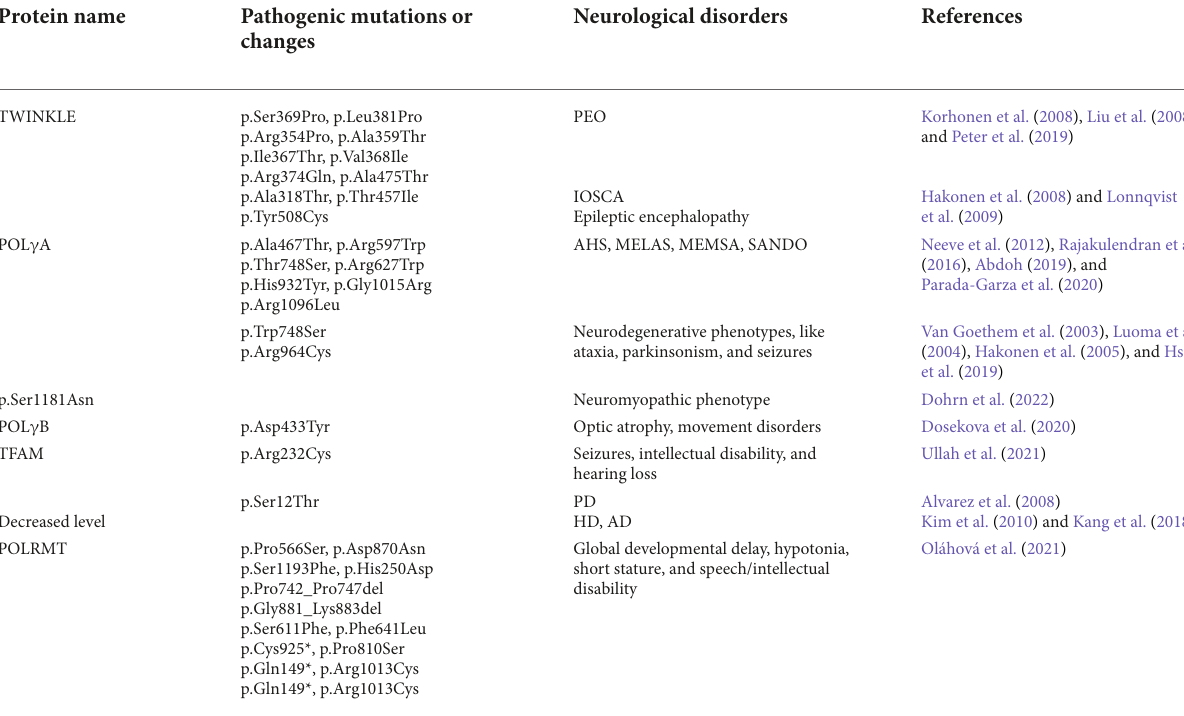
TABLE 3 Neurological diseases caused by protein variants involved in mitochondrial genome